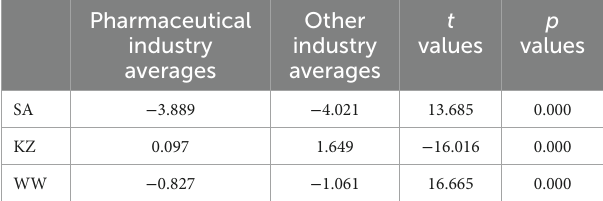
TABLE 8 Comparison of financing constraint